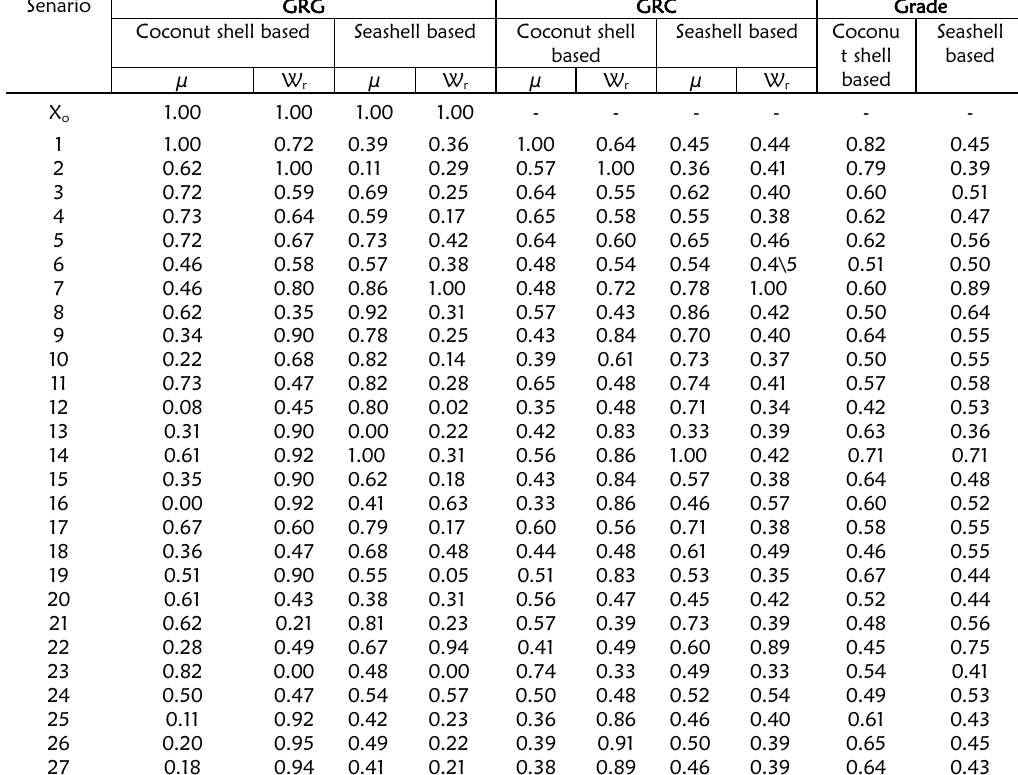
Table 5: Results of Grey relational analysis (GRA)